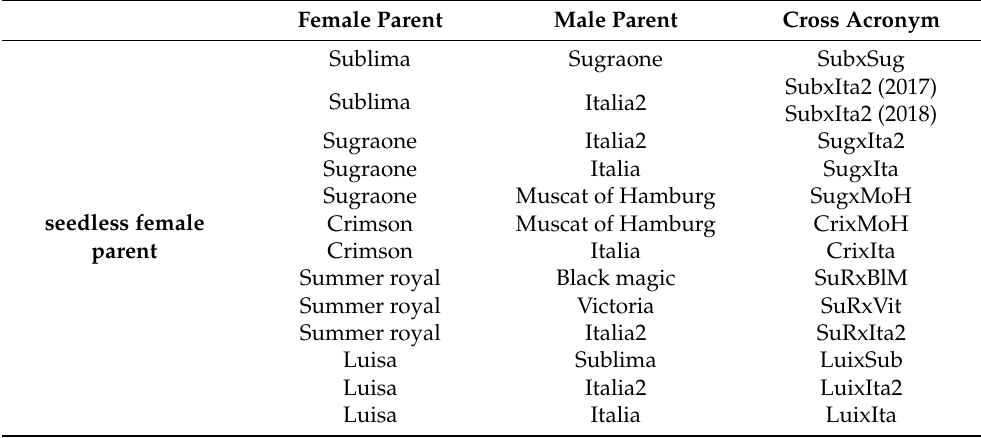
Table 1. Cultivars used and cross combination acronyms: 24 cross combination were performed using seedless and seeded